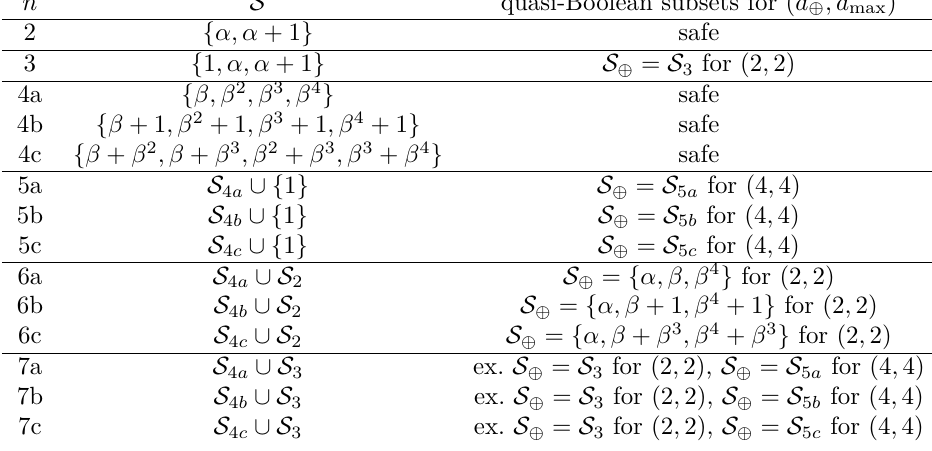
Table 1: Frobenius-stable sets of interpolation points and their quasi-Booleanness. n S quasi-Boolean subsets for ( d ⊕ , d max ) 2 { α, α + 1 }